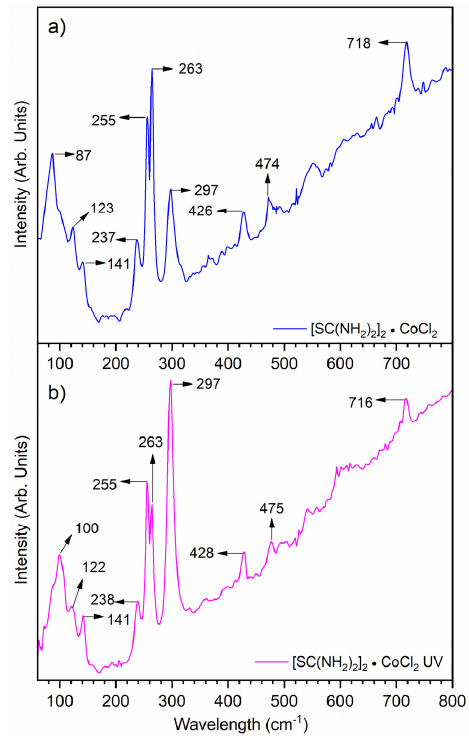
Figure 10. [SC(NH 2 ) 2 ] 2 · CoCl 2 Raman spectra ( a ) without UV assistance; ( b ) with UV assistance. Table 1. Vibrational modes in cobalt–thiourea complex crystals without and with UV assistance.